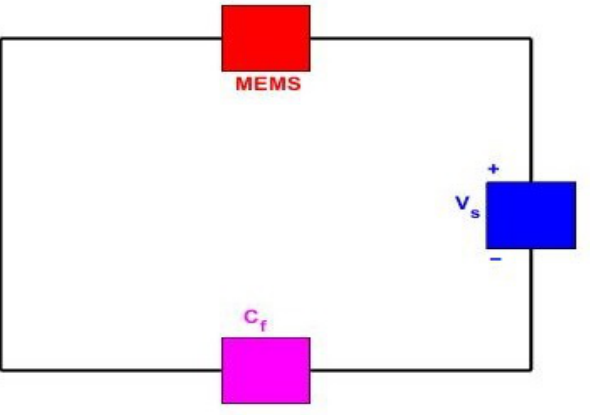
Figure 2. The basic capacitive control